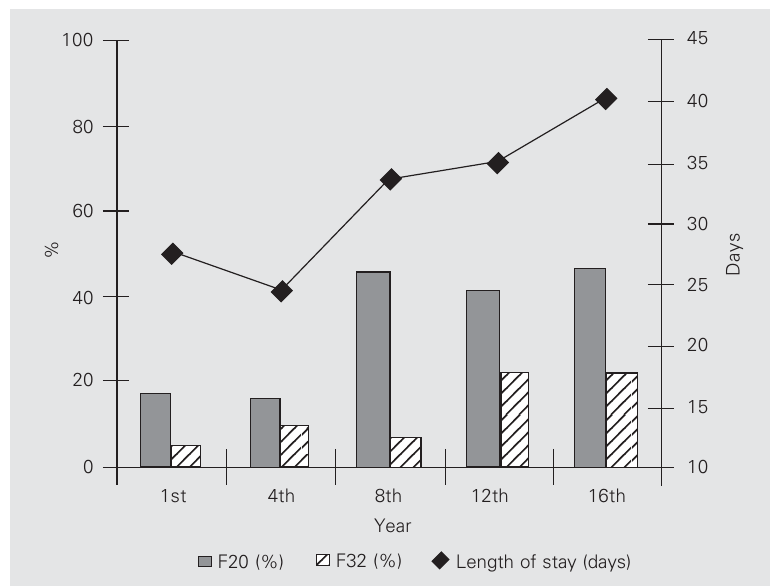
Figure 1. Percentage of patients with schizophrenia (F20) and affective disorder (F32) and average length of stay in the Psychiatric Unit of the Ribeirão Preto General Hospital, during the 1st, 4th, 8th, 12th and 16th years of